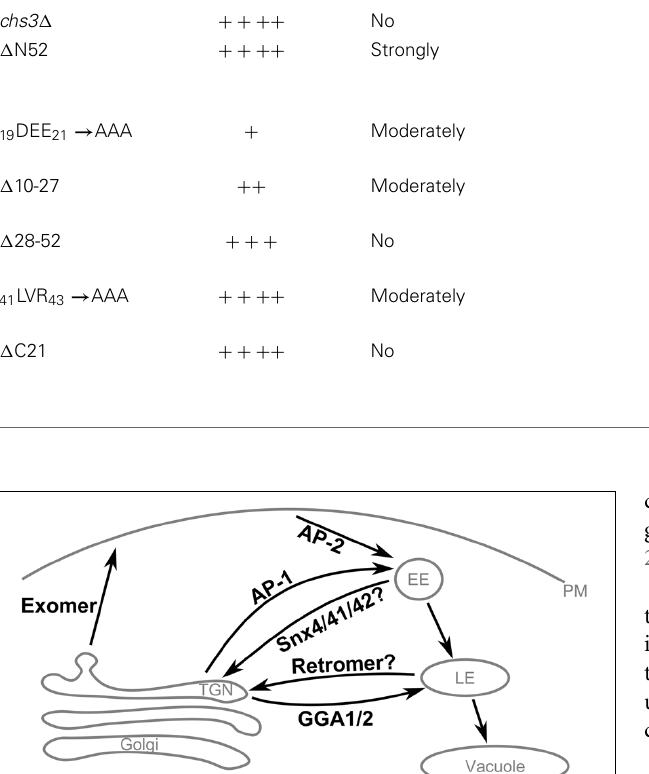
Table 3 | Summary of Chs3 mutations analyzed in this study and their effect on trafficking. Mutant